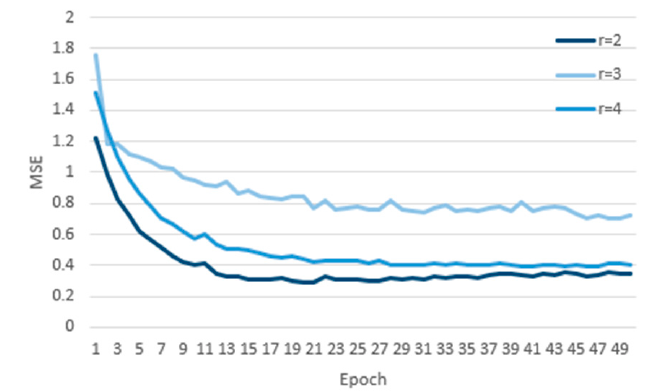
Figure 2. Loss curves at different dilation rates. In order to prevent the dimensionality of the data from changing during the input processing, the connection method of the network we used is the residual module con- nection, which can make the information jump-delivery across the layer in the network. The transformation function of the ordinary connection is H(x), while the transformation function of the residual block is F(x) = H(x) − x, which only needs to learn to modify part of the input x, instead of all input x. It has great significance in solving the problem of vanishing and exploding gradients in deep networks. TCN contains two layers of causal convolution and nonlinear mapping, using rectified linear unit (ReLU) as the activation function, and adding WeightNorm and Dropout for regularization. The structure is shown in Figure 3.